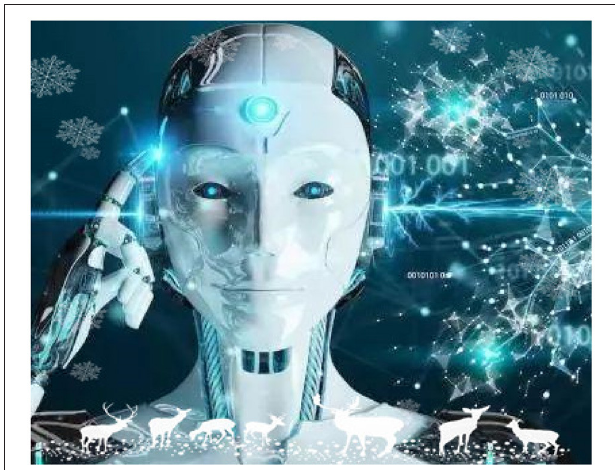
FIGURE 1 | Virtual reality (VR)